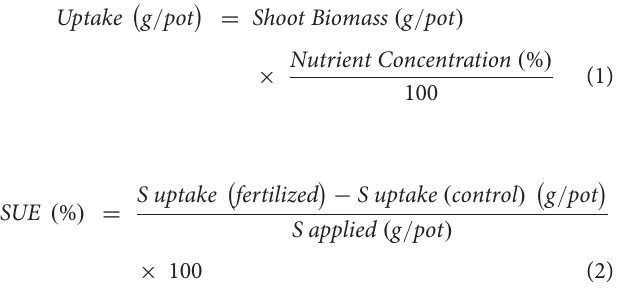
Figure 2c : A (top layer, between 0 and 10 cm depth), B (middle layer, between 10 and 30 cm depth), and C (bottom layer, below 30 cm depth). Roots were separated from the substrate samples with a sieve (9 mm × 5 mm mesh